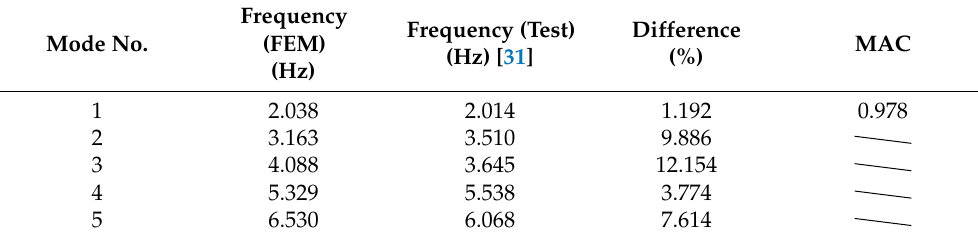
Table 1. Comparison of the first five frequencies by the proposed model and experimental results.